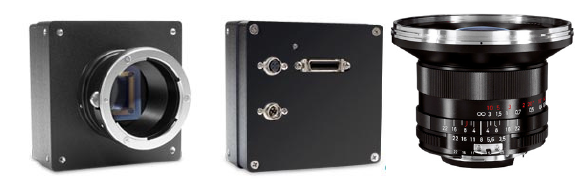
Figure 3. Camera and